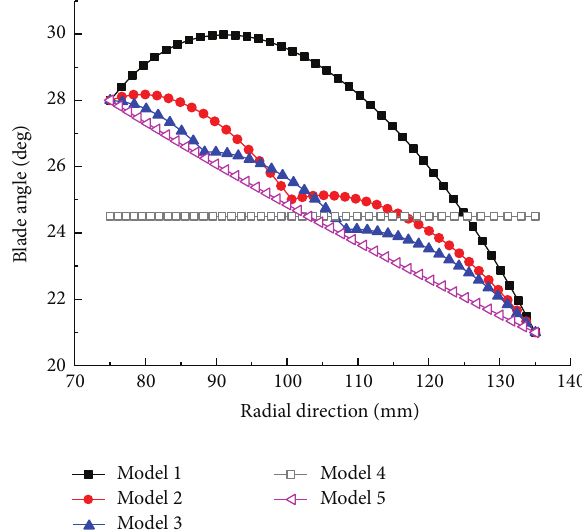
Figure 6: Blade angle distribution along the radial direction of 5 impeller blades.